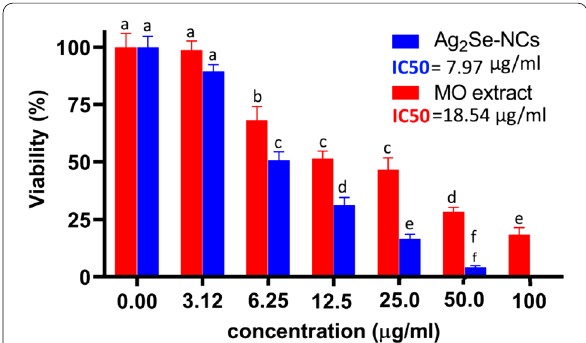
Fig. 8 Cytotoxicity of Ag 2 Se-NCs and MO extract in HepG2 cell line. Data are presented as mean p < 0.001. Different superscript shows significant differences between